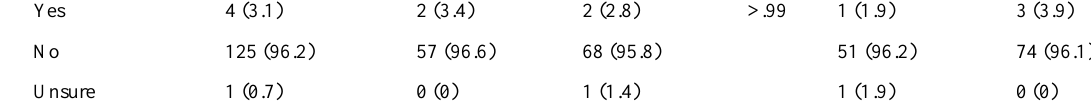
.45Do you have any concerns about using text messaging for your health